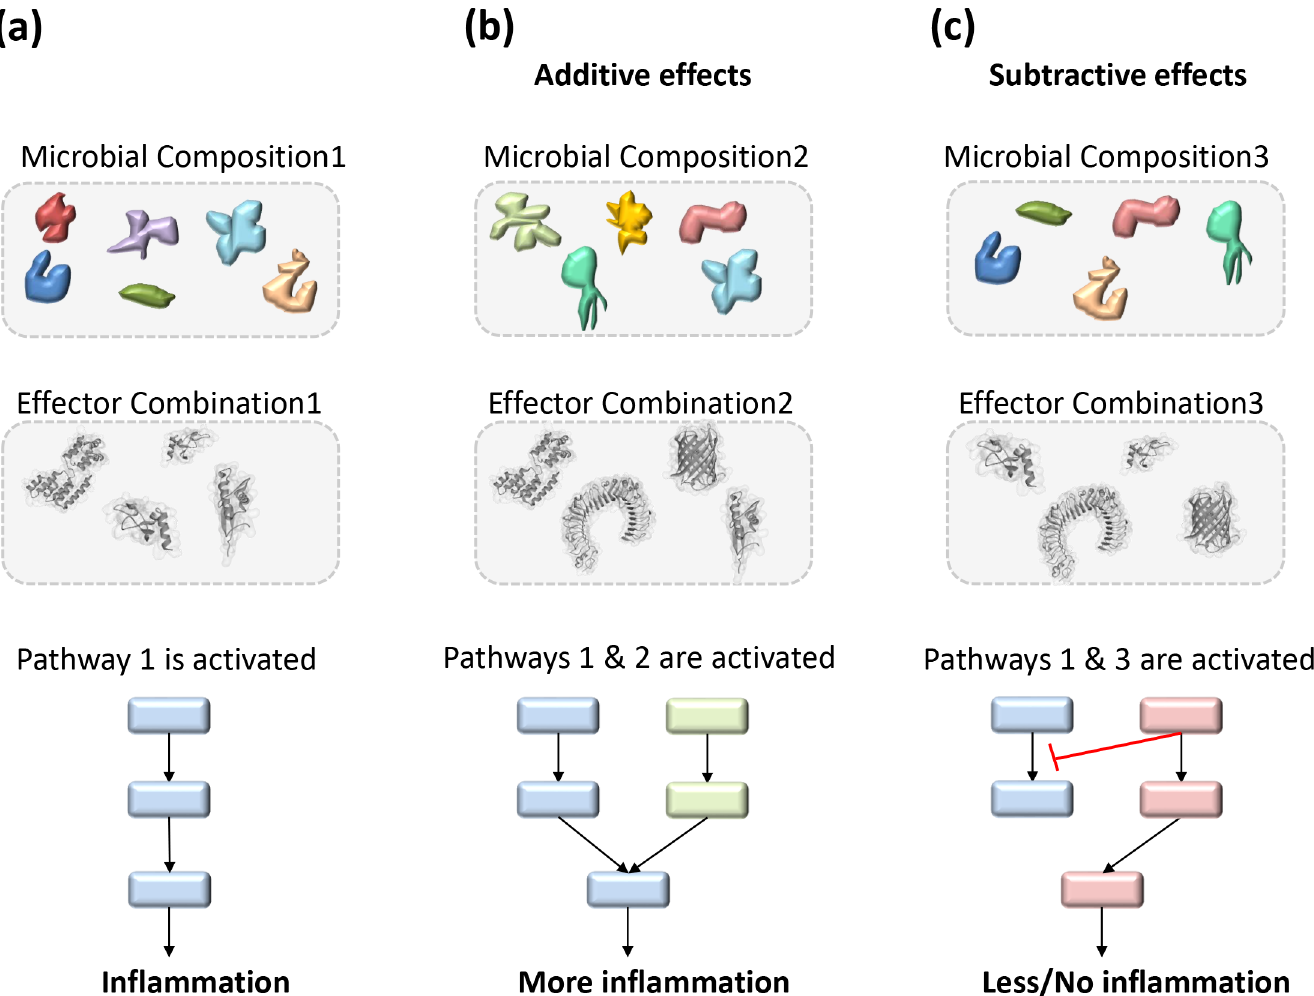
Fig 1. Distinct microbial compositions may lead to different outcomes (hypothetical scenario). Combinatorial effects of microbialeffectors and the active host pathwaysdeterminethe cell response. (a) Composition1 has certain microorganisms that secrete effector protein combination1. These effectors activate pathway1in the host, which producespro-inflammatory cytokines. (b) Composition2 secretes effector combination2 and activates pathway2in additionto pathway1. Additive effects of these two pathways amplifiesthe signal and promotes inflammation (cross-activation). (c) Microbial composition3utilize effector combination3 to activate both pathway 1 and 3, which have opposingoutcomes. Subtractive effects of these pathways result in no inflammation (cross-inhibition).